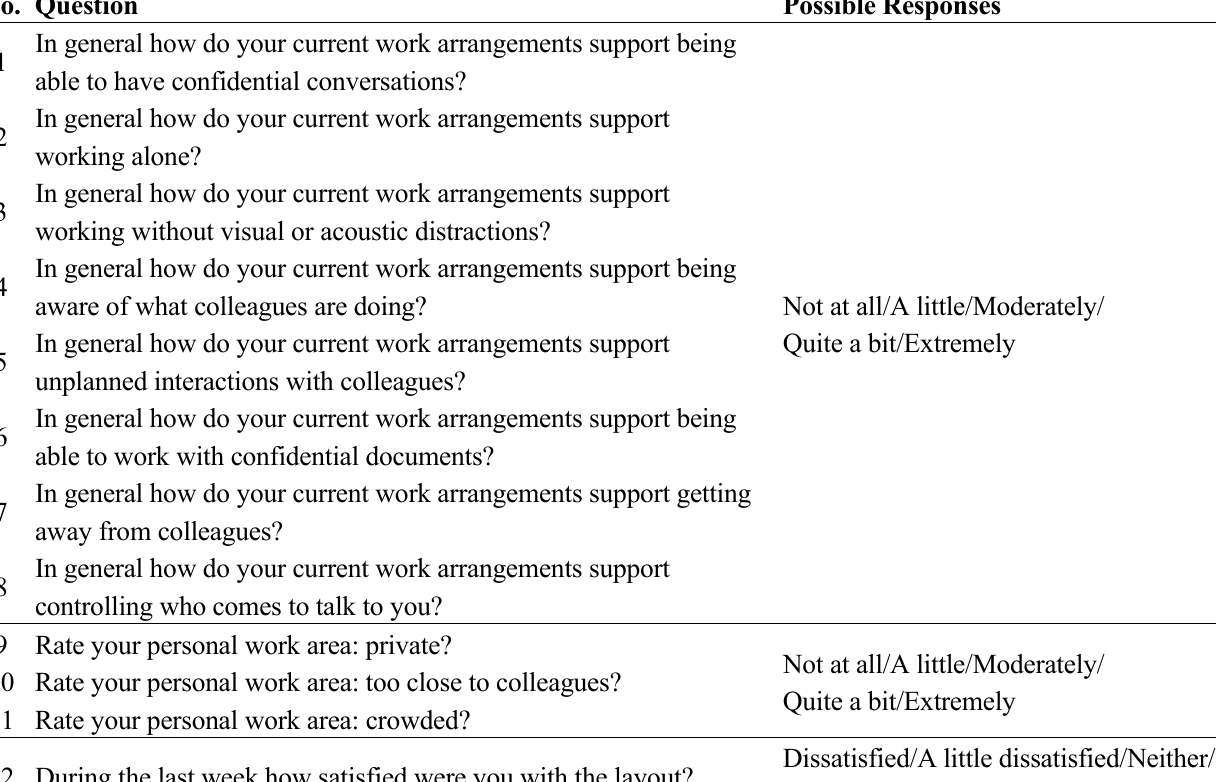
Table 4 . Survey questions developed for this